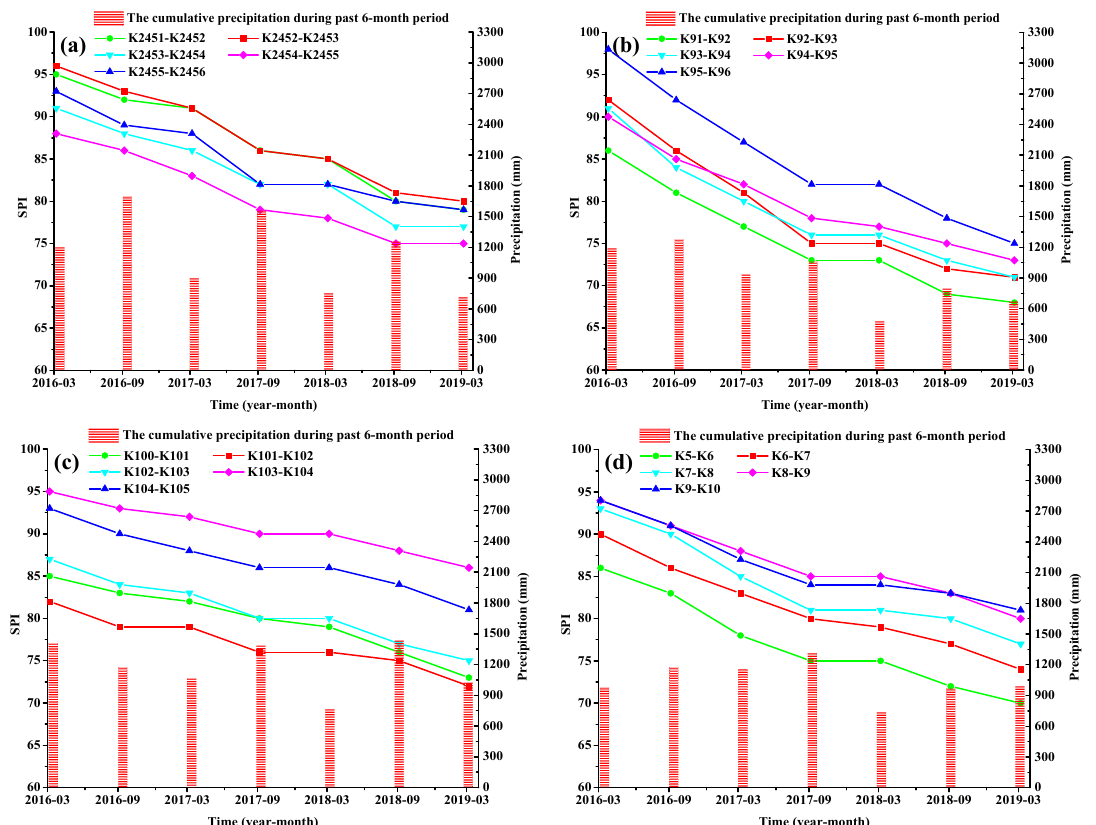
Figure 6. Accumulated precipitation, time, and SPI from the test sites: ( a ) K2451–K2456 of G105; ( b ) K91–K96 of S223; ( c ) K100–K105 of S270; and ( d ) K5–K10 of S356.